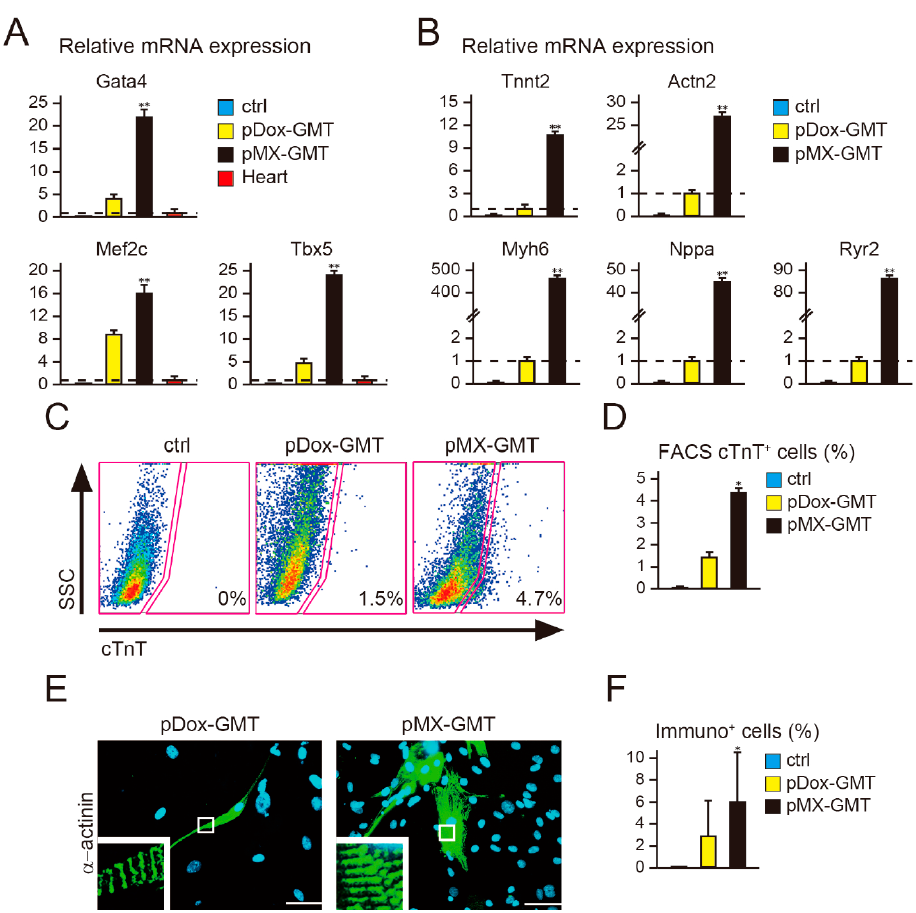
Figure 2. Cardiac reprogramming is more efficient using pMX-GMT (a Mixture of pMX-Gata4, -Mef2c, and -Tbx5) than that using pDox-GMT (a Mixture of pDox-Gata4, -Mef2c, and -Tbx5). ( A ) qRT-PCR for Gata4, Mef2c, and Tbx5 expression in mouse embryonic fibroblasts (MEFs), pDox-GMT-transduced MEFs, pMX-GMT-transduced MEFs, and heart tissue ( n = 3, independent triplicate experiments). Data were normalized to the values of heart tissue (the dash lines); ( B ) qRT-PCR for TnnT2, Myh6, Nppa, and Ryr2 mRNA expression in mouse embryonic fibroblasts (MEFs), pDox-GMT-transduced MEFs and pMX-GMT-transduced MEFs after one week ( n = 3 independent triplicate experiments). Data were normalized to the values of pDox-GMT-transduced MEFs (the dash lines); ( C ) FACS analyses of cardiac troponin T (cTnT) expression induced by pDox-GMT in the presence of Dox or pMX-GMT after one week; ( D ) quantitative data of ( C ) ( n = 3 independent triplicate experiments); ( E ) immunocytochemistry for α -actinin in pDox-GMT-transduced MEFs in the presence of Dox, and pMX-GMT-transduced MEFs, after four weeks. The high-magnification views in the insets show the sarcomeric organization; ( F ) quantitation of α -actinin-positive cells ( n = 3 independent triplicate experiments). All data are presented as mean ± SD. * p < 0.05, ** p < 0.01 vs. the relevant control. The scale bars represent 100 µm.